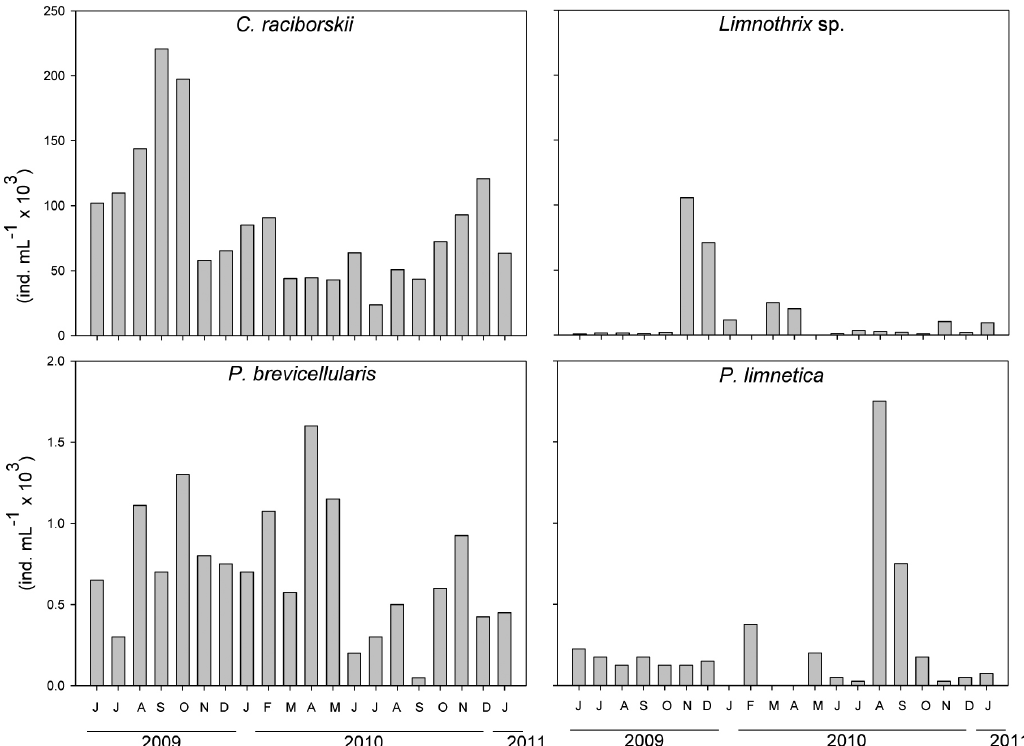
Figure 6. Cyanobacteria species density more frequent during sampling in Peri Lake, from June/2009 to